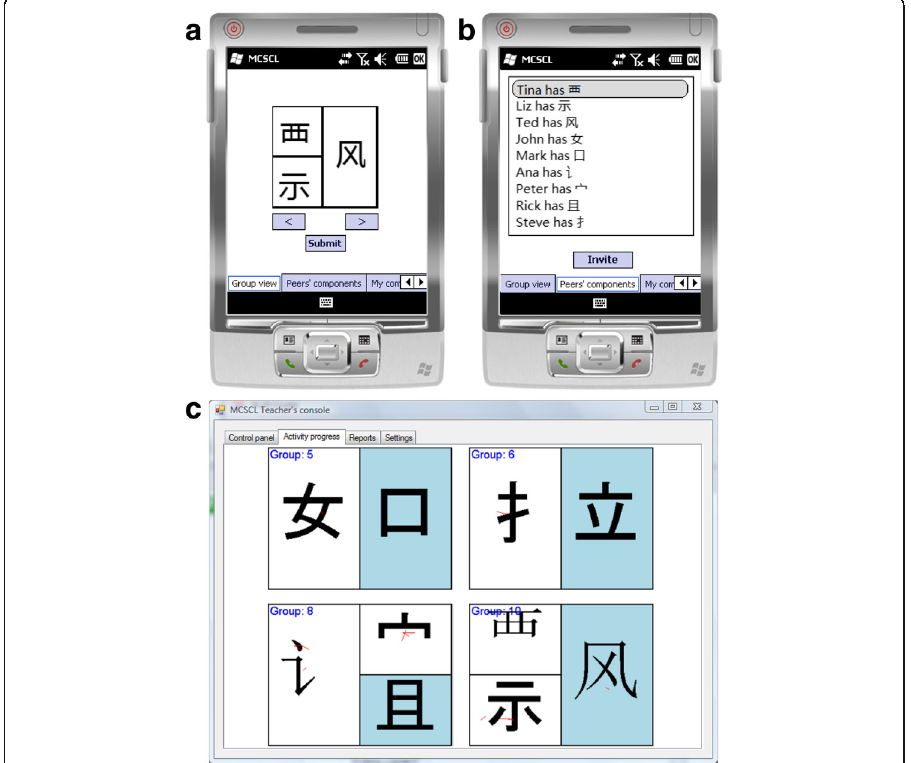
Fig. 3 a Student ’ s smartphone application displaying an assembled character. b Student ’ s